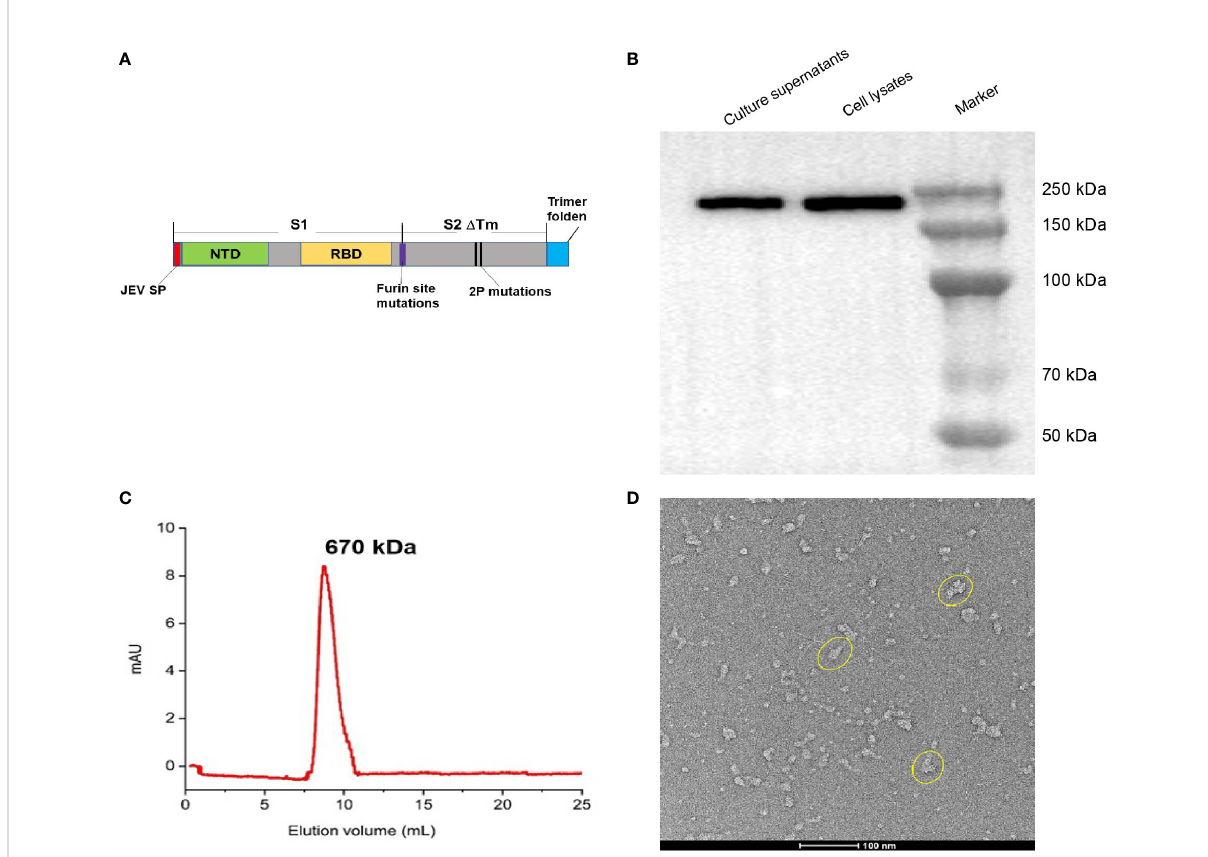
FIGURE 1 Construction and characterization of BV-AdCoV-1. (A) Schematic diagram of the DNA sequence coding for the trimeric prefusion spike (Pre-S). The extracellular domain of SARS-COV-2 spike protein (1-1201 aa) was fused to the T4 fi britin trimerization motif, and the original spike ’ s signal peptide was replaced by the Japanese encephalitis virus E protein signal peptide (JEV SP). Mutations in the furin cleavage site and proline substitutions (K986P, V987P) were introduced. (B) Western blot analysis of HEK 293 cell lysate and supernatant. (C) Pre-S protein elution pro fi le on a calibrated Superdex 200 increase 10/300 GL. (D) Cryo-EM picture of puri fi ed pre-S